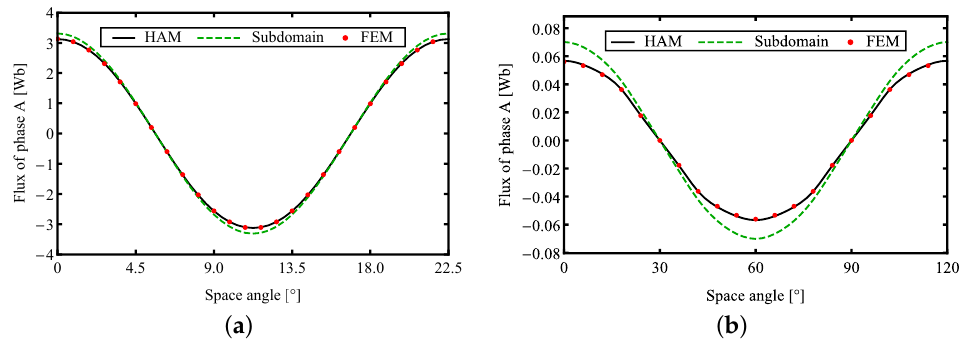
Figure 18. The magnetic flux of Phase A under open-circuit condition: ( a ) Machine I and ( b ) Machine